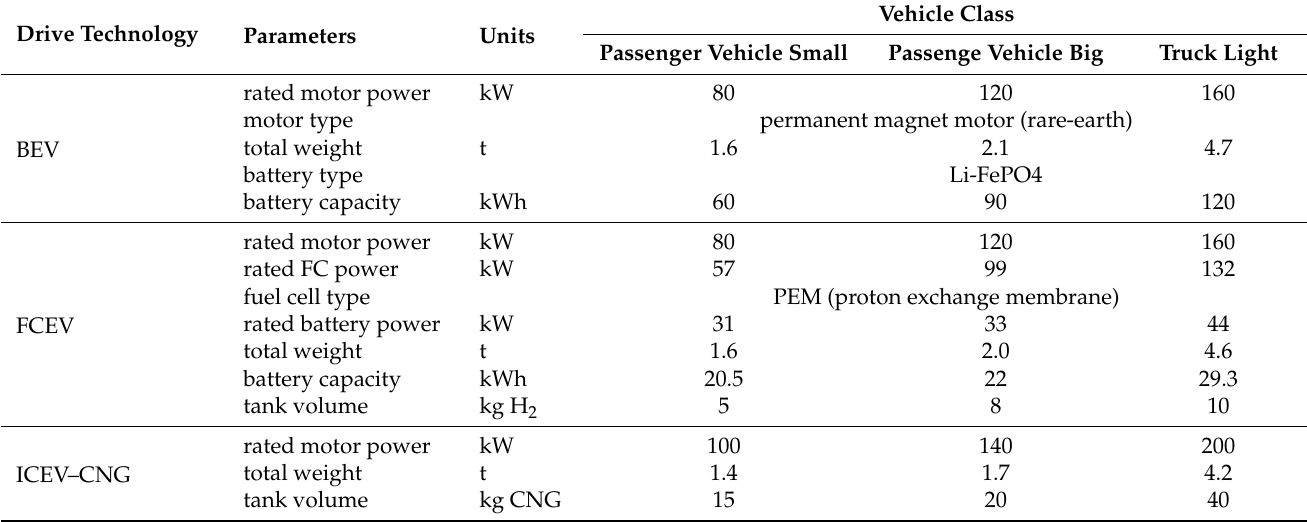
Table 1. Definition of vehicle classes (further parameters are given in Appendix